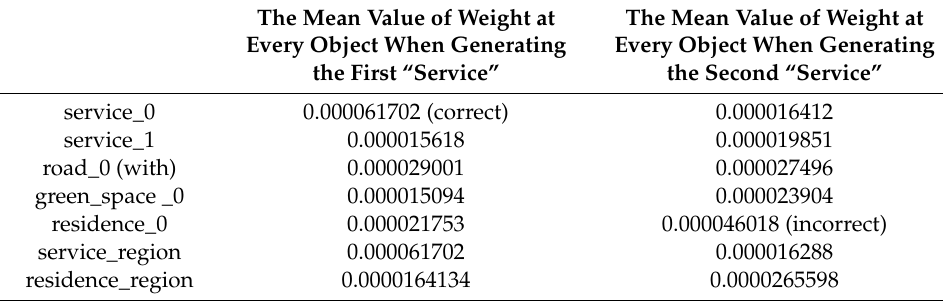
Table 2. Mean value of remote sensing